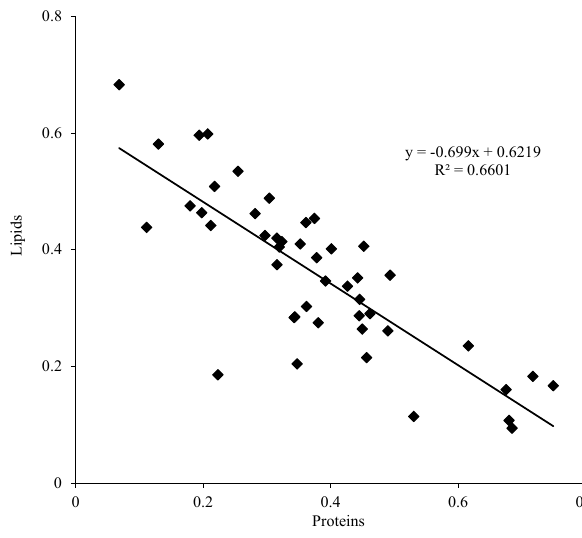
Figure 4. The inverse relationship between lipid compositions and protein